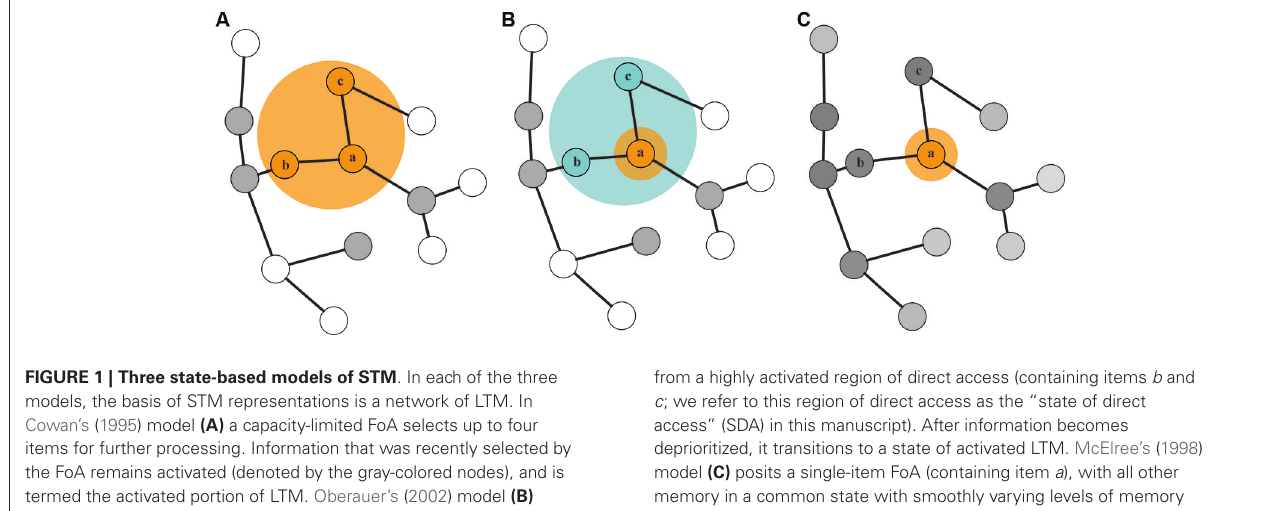
FIGURE 1 | Three state-based models of STM . In each of the three models, the basis of STM representations is a network of LTM. In Cowan’s (1995) model (A) a capacity-limited FoA selects up to four items for further processing. Information that was recently selected by the FoA remains activated (denoted by the gray-colored nodes), and is termed the activated portion of LTM. Oberauer’s (2002) model (B) includes a narrow FoA which can efficiently select information (item a )